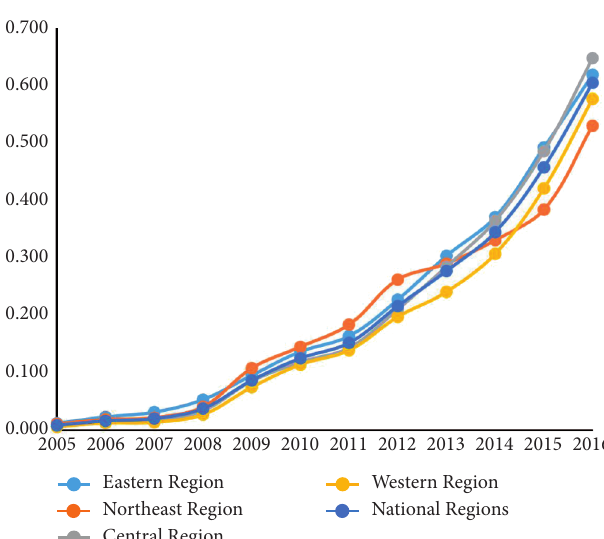
Figure 2: Coupling coordination degree of green economy, edu- cation development, and technological